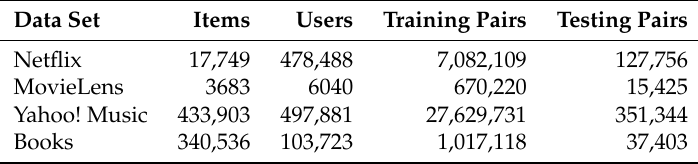
Table 1. Data sets used in the